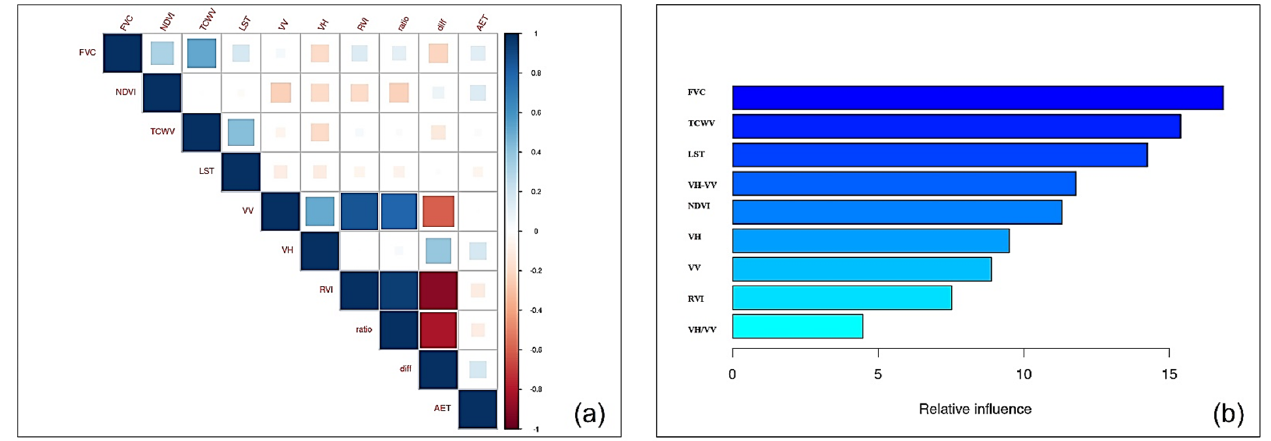
Figure 6. ( a ) Pearson’s correlation between the AET and remotely sensed data and ( b ) variables’ importance based on the GBM model. importance based on the GBM